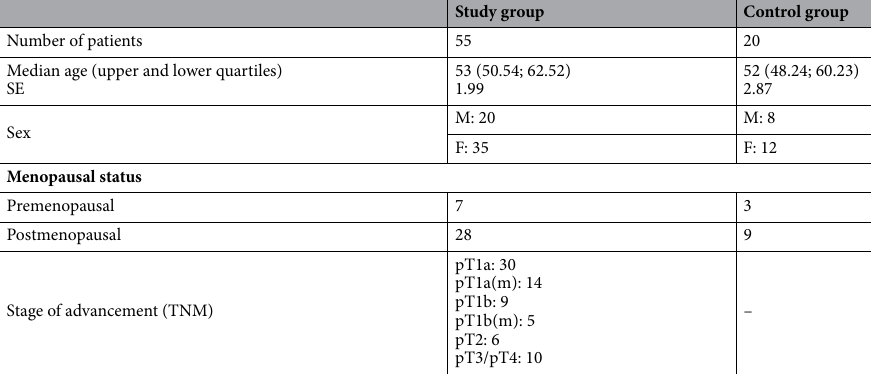
Table 3. The study and the control group characteristics. F female, M male, (m) multifocal, p papillary cancer, TNM cancer tumor-node-metastasis classification for differentiated and anaplastic thyroid cancer (based on the characteristics of primary tumor site (pT)), pT1a tumor size ≤ 1 cm in greatest dimension limited to the thyroid, pT1b tumor > 1 cm but ≤ 2 cm in greatest dimension, limited to the thyroid, pT2 tumor size > 2 cm but ≤ 4 cm, limited to the thyroid, pT3/pT4 tumor size > 4 cm, with gross extrathyroidal extension, SE standard error 53